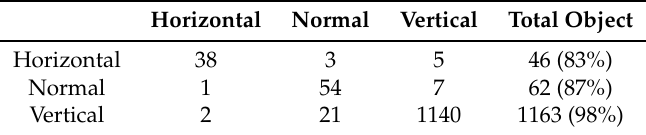
Table 5. Result of the classification based on the aspect